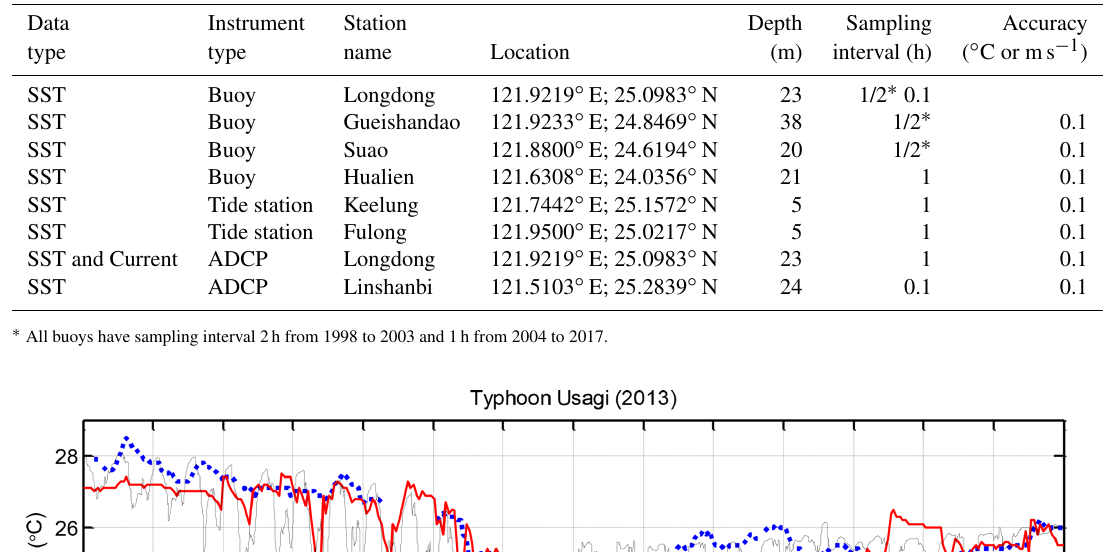
Table 2. List of field data used in this study.